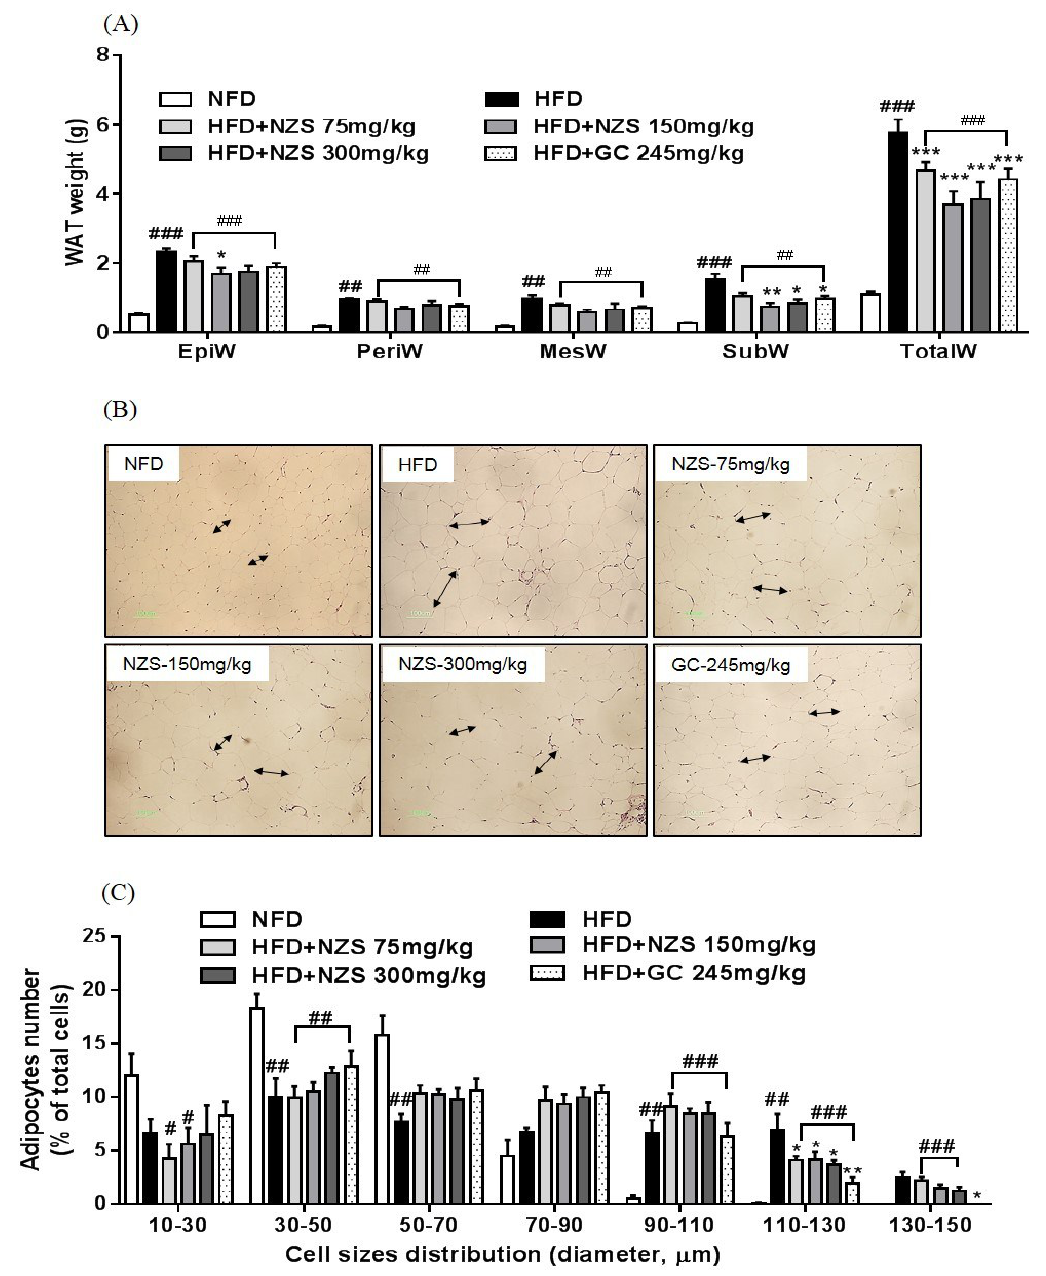
Figure 2. Effects of NZS on white adipose tissue (WAT) weight and histological analysis in HFD-induced obese mice. ( A ) WAT, ( B ) H&E staining, and ( C ) distribution of cell diameters. EpiW: epididymal WAT; PeriW: perirenal WAT; MesW: mesenteric WAT; SubW: inguinal WAT; TotalW: EpiW + PeriW + MesW + SubW. NFD: normal-fat diet; HFD: high-fat diet; NZS: Tetragonia tetragonoides (Pall.) Kuntze extract (New Zealand spinach); GC: Garcinia cambogia extract. Values are expressed as